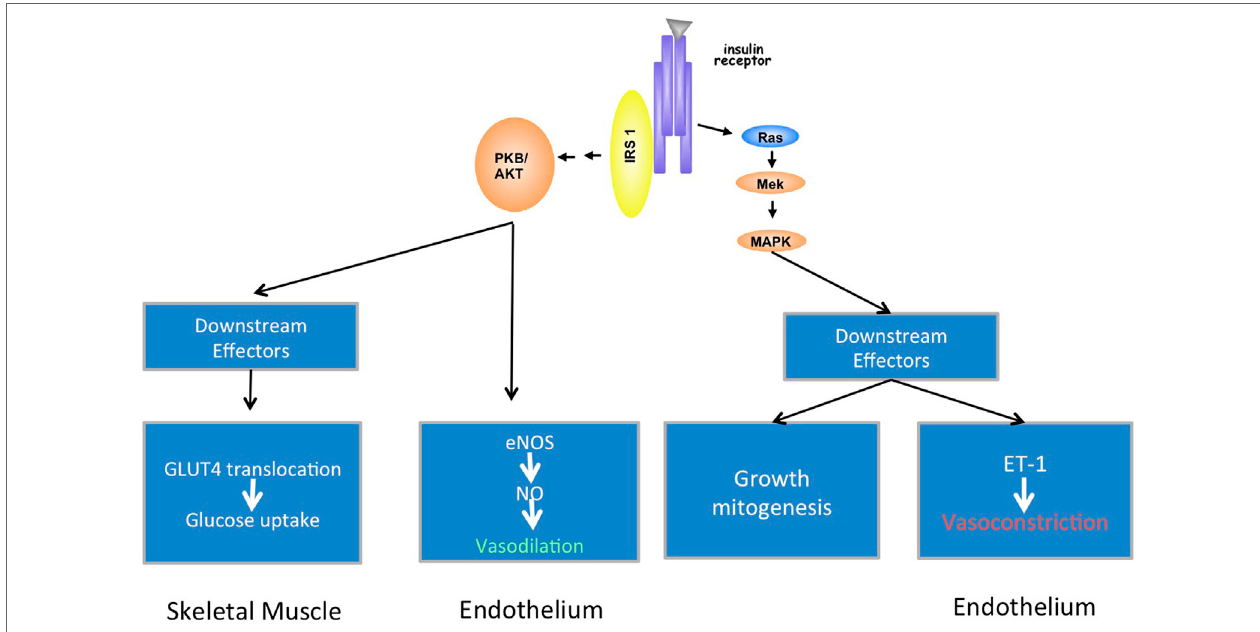
FiGURe 1 | Metabolic and vascular effects of insulin. Under physiologic conditions, the activated insulin receptor on endothelial cells leads to phosphorylation of endothelial nitric oxide synthase (eNOS) via activation of insulin receptor substrate (IRS) and phosphoinositide-3-kinase (a). This results in vasodilation via NO production. This branch also regulates GLUT4 translocation and glucose uptake in muscle cells. The mitogen-activated protein kinase (MAPK) pathway controls secretion of vasoconstrictive ET-1 in endothelial cells, and cell growth and mitogenesis in cells at large. Inflammation reduces NO production via blocking insulin receptor signaling at the level of the IRS-1